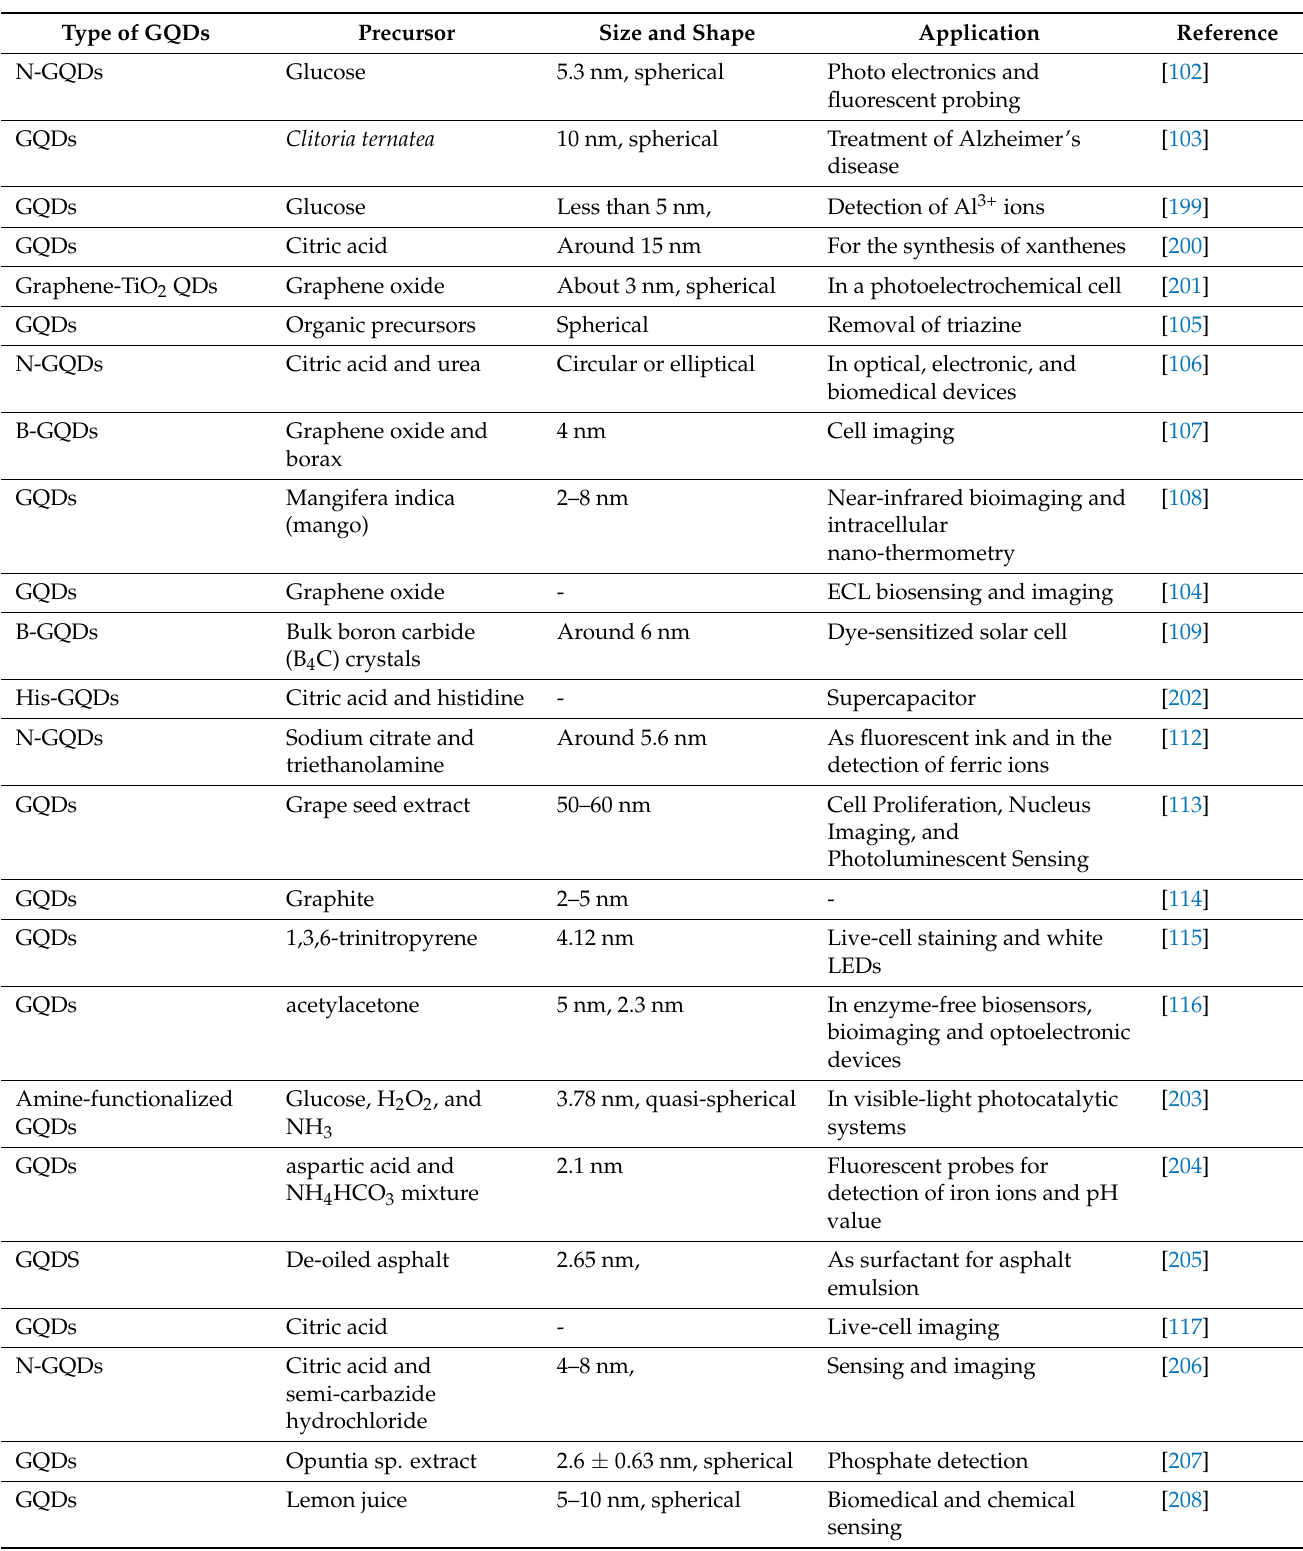
Table 1. The microwave-assisted methods for the preparation of